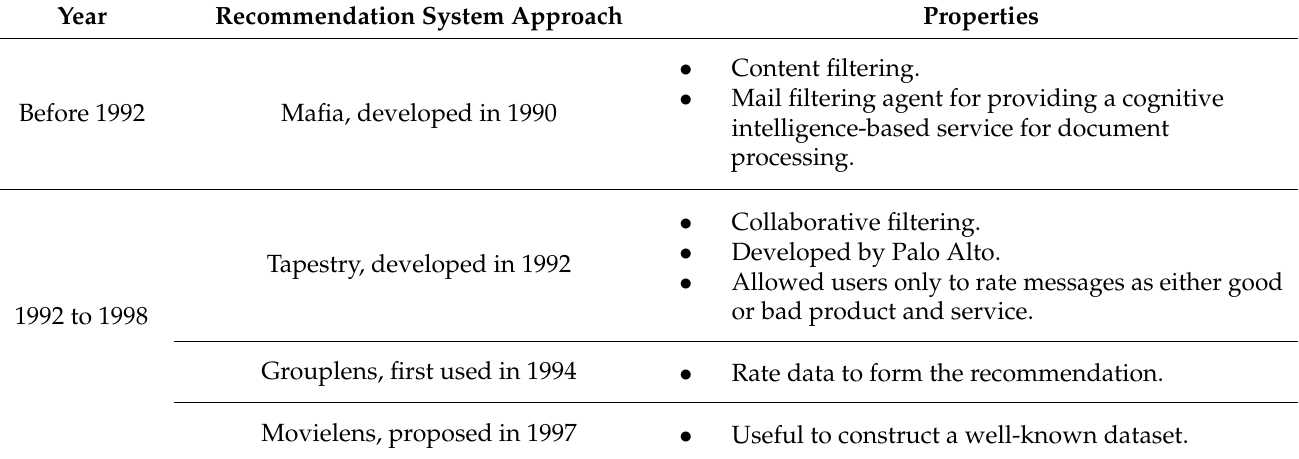
Table 1. History of recommendation systems; produced by the authors based on